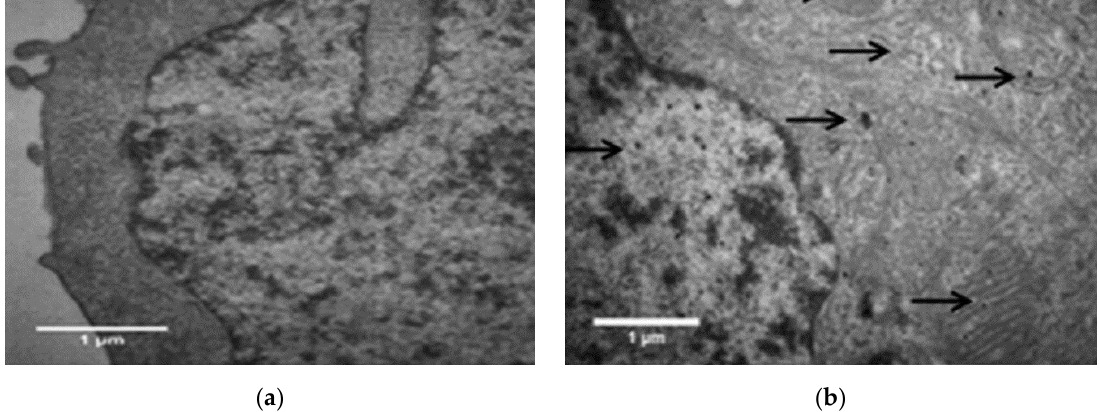
Figure 13. TEM images showing the internalization of pure ( a ) and Gd-doped ( b ) ZnO nanoparticles in lung carcinoma (SKLC-6) cells. Adapted from ref. [286] .